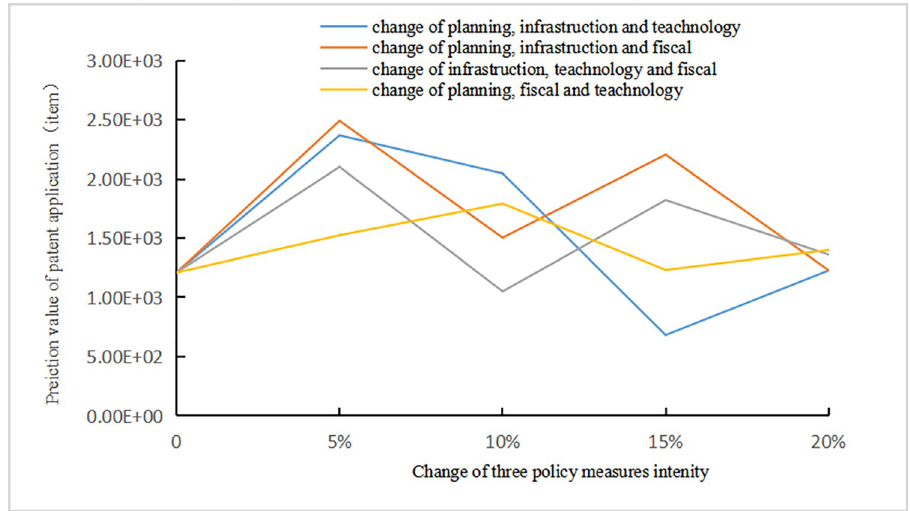
Fig 9. Relationship between the intensity of three policy measures and number of patent